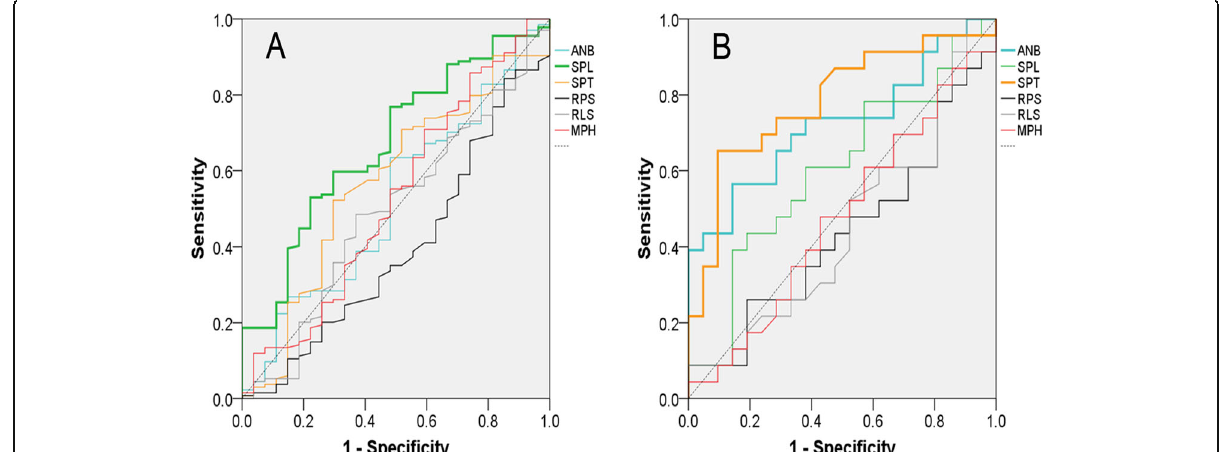
Fig. 2 Receiver operating characteristic curves in male ( a ) and female ( b ) for angle from sella to nasion to A point (ANB), soft palate length (SPL), soft palate thickness (SPT), retropalatal space (RPS), retrolingual space (RLS), linear distance along the perpendicular plane from hyoid to mandibular plane (MPH)